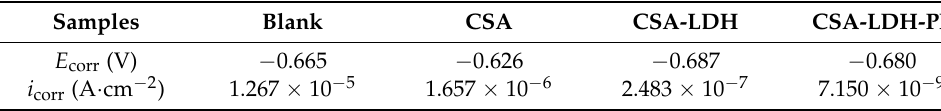
Table 5. Fitting results of the polarization curves in Figure